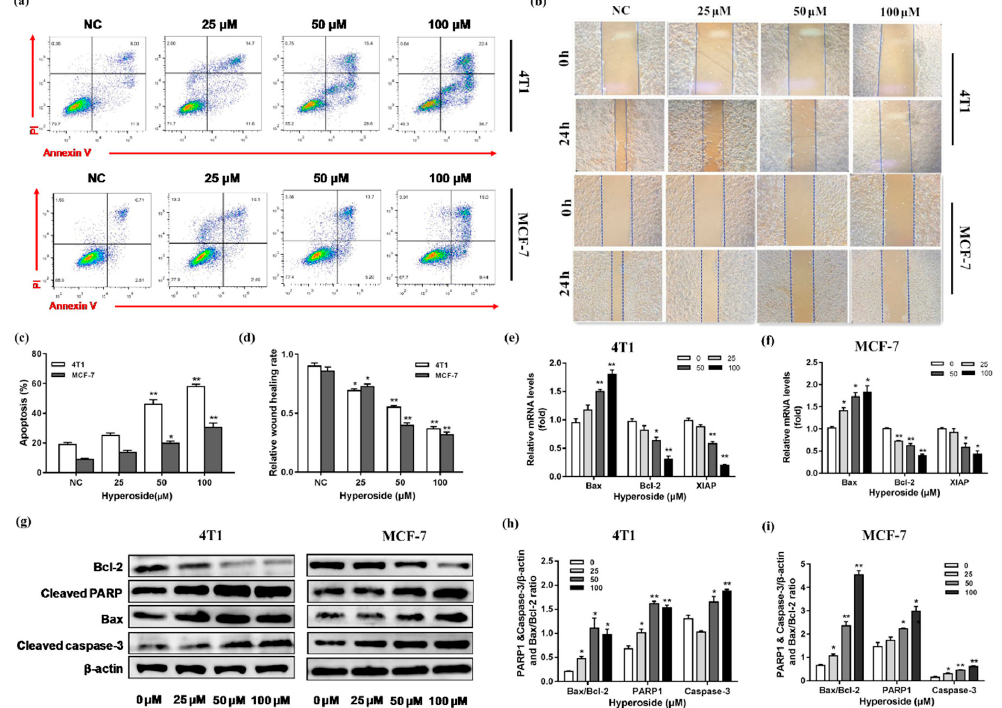
Figure 2. Effects of hyperoside on apoptosis and migration of breast cancer cells. MCF-7 cells and 4T1